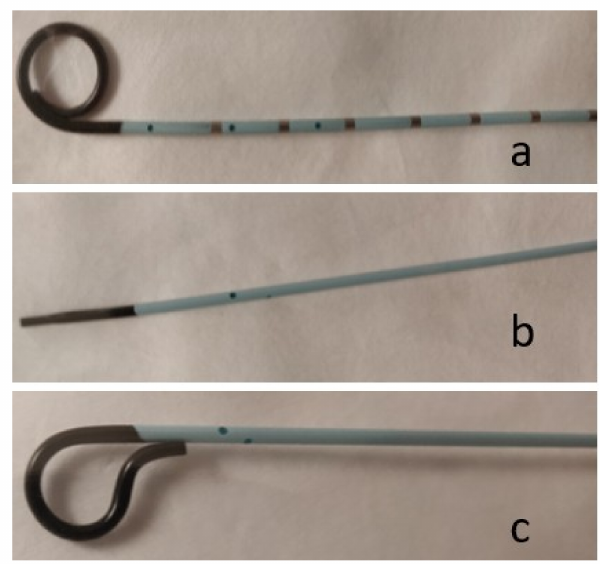
Figure5. Flushcatheters. (a)Flushpigtailcatheter, (b)straightflushcatheter, and(c)OmniFlushcatheter.